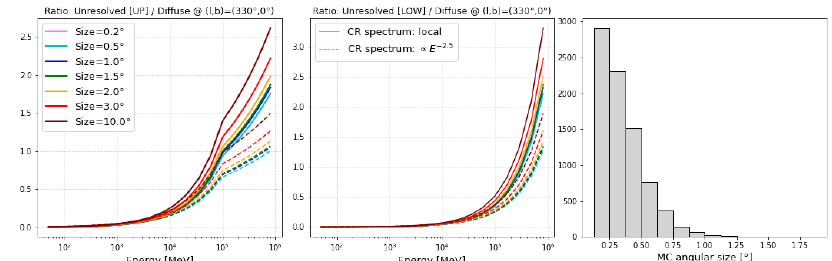
Figure 1. The ratio between the unresolved sources and the truly di ff use emission integrated over di ff erent areas. The right-most panel shows the distribution of extensions of MCs in the Milky Way [6]